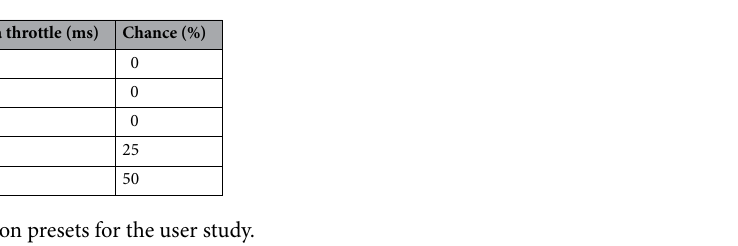
Figure 2. ( a ) The network topology for our system. PC1 is connected to both PC2 and PC3, but PC2 and PC3 are not connected to each other. In this example, 500 ms of latency is being applied using a software tool Clumsy. ( b ) The VR room layout for various user positions and a possible fire spawn order. The small circles represent the fire locations, and the larger circles represent the starting locations for each user. Each number is the fire location ID, and each subscript represents an example ordering of the fires (i.e., the order in this example is 084623715).